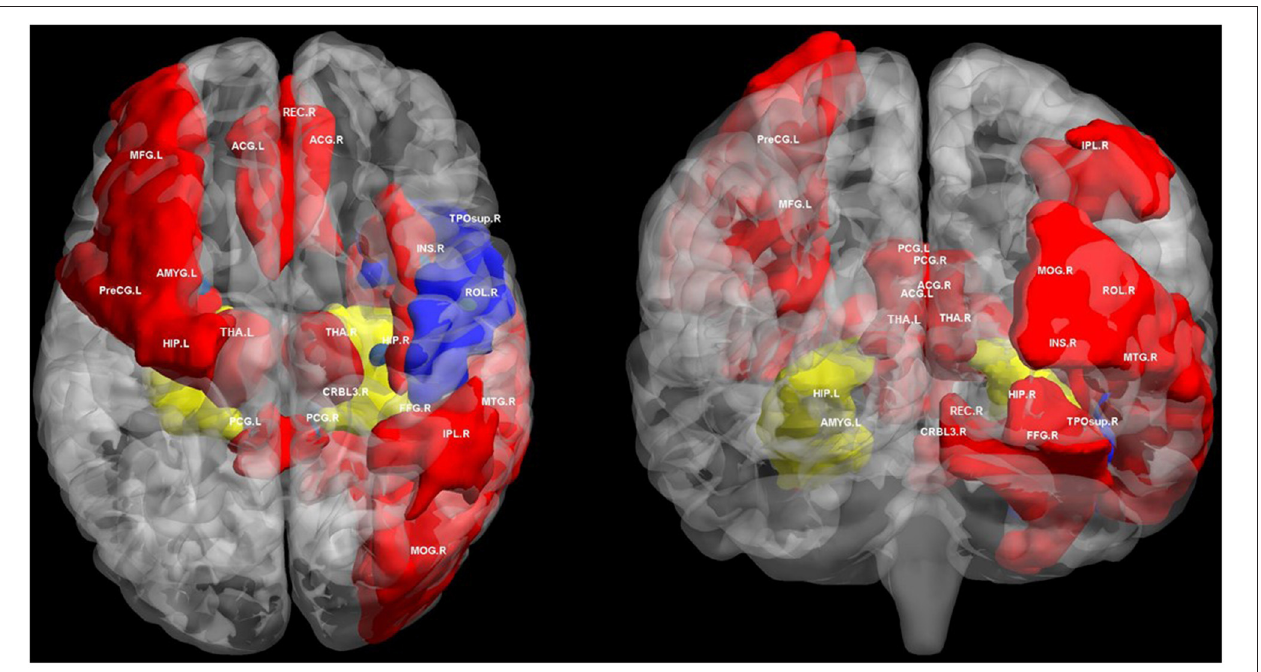
FIGURE 1 | Regions of altered structural and functional connectivity in T2DM. We summarize previously reported brain regions of T2DM related cognitive impairment based on structural connectivity and functional connectivity analysis. We extracted these brain regions from automated anatomical labeling (AAL) and displayed them in BrainNet Viewer (http://www.nitrc.org/projects/bnv/). Blue regions only indicate brain regions with disrupted structural connectivity in T2DM related cognitive impairment. Red regions only indicates brain regions with disrupted functional connectivity in T2DM related cognitive impairment. The yellow regions indicate the brain area where both structural and functional connectivity was interrupted in T2DM related cognitive impairment, mainly the hippocampus. PreCG, precental gyrus; MFG, middle frontal gyrus; ROL, rolandic operculum; REC, gyrus rectus; INS, insula; ACG, anterior cingulate and paracingulate gyri; PCG, posterior cingulate gyrus; HIP, hippocampus; AMYG, amygdala; MOG, middle occipital gyrus; FFG, fusiform gyrus; IPL, inferior parietal, but supramarginal and angular gyri; THA, thalamus; TPOsup, temporal pole: superior temporal gyrus; MTG, middle temporal gyrus; CRBL3, cerebellum superior; R, right; L,